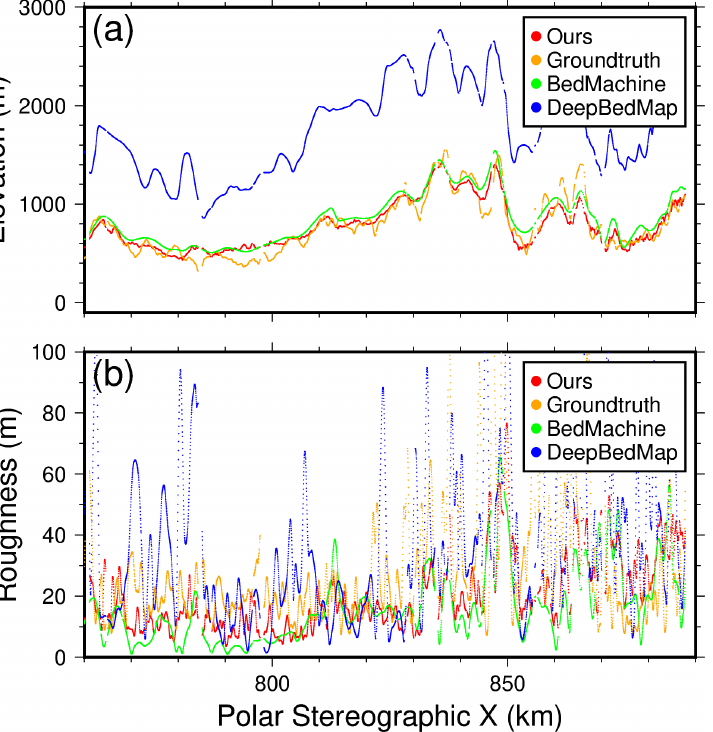
Figure 13. Comparison bed elevation ( a ) and bed roughness ( b ) of each grid product over a transect in Dome F (see Figure 11f, orange